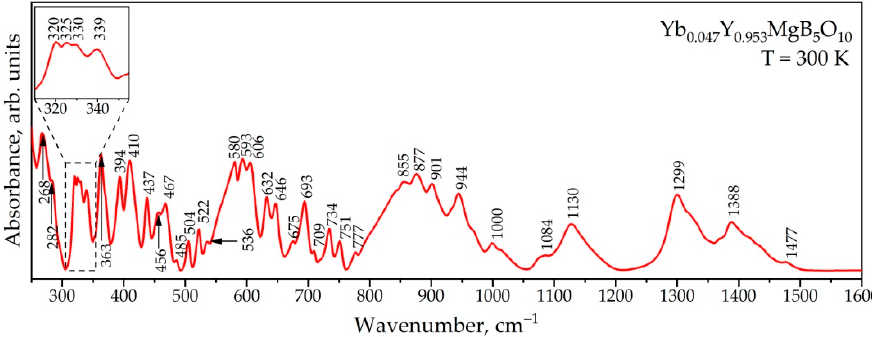
Figure 4. ATR-FTIR spectrum of Yb:YMBO in the range 250–1600 cm − 1 at room temperature. Data collected during TGA-DSC measurements in the temperature range 50–1500 ◦ C are shown in Figure 5a,b. The DSC curve exhibits an endothermal peak at ~1051 ◦ C. The absence of an exothermal peak on the cooling curve (insert on Figure 5a) and sample appearance suggest different thermal behavior from that described in [52]. The residue in the crucible after TGA-DSC measurements under heating up to 1100 ◦ C was a white, opaque, dense mass. Repeated heating of the sample in the temperature range 50–1100 ◦ C resulted in a small endothermic peak at ~1047 ◦ C (Figure 5b), which may also indicate the decomposition of the studied compound. PXRD analysis revealed the existence of YBO 3 and Mg 2 B 2 O 10 (Figure 6).